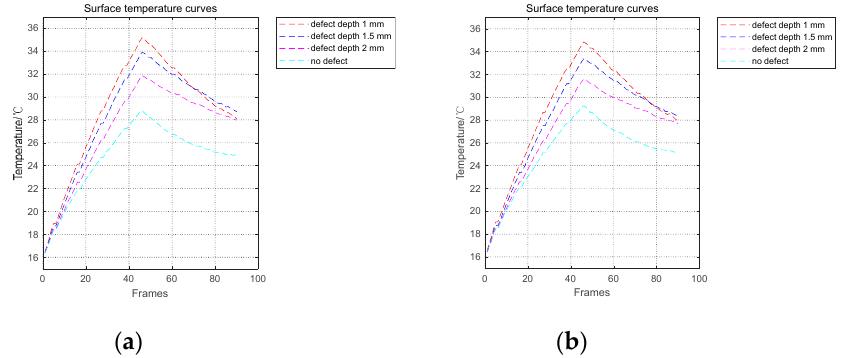
Figure 10. Surface temperature curves of different defect depth: ( a ) diameter is 16 mm; ( b ) diameter is 10 mm.